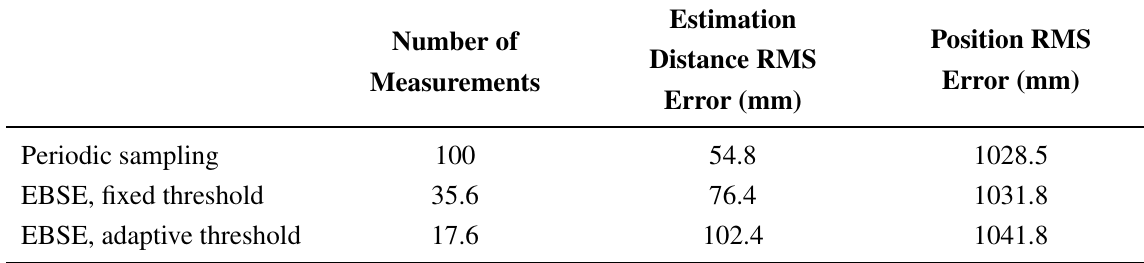
Table 2. Numerical results during approaching time (average results of 20